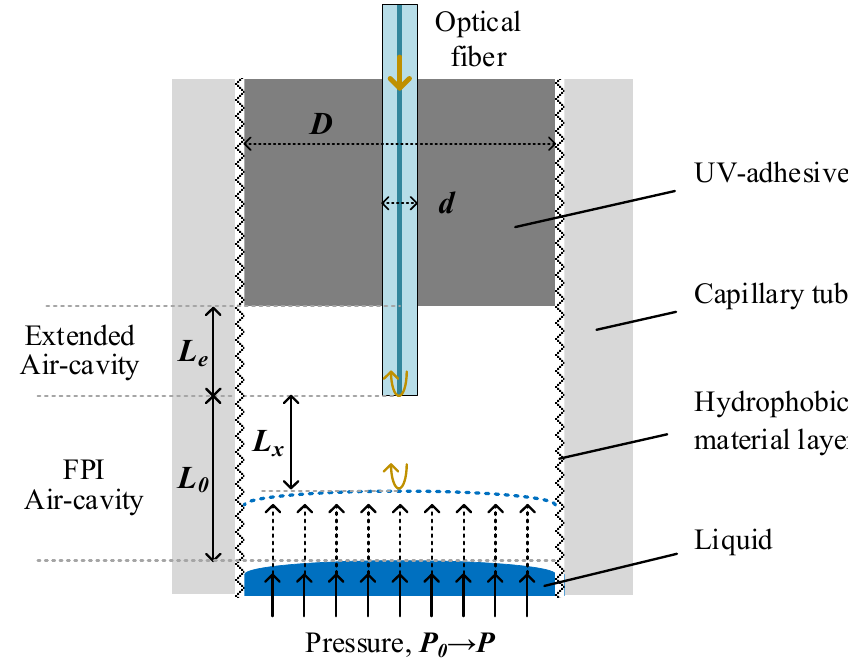
Figure 1. Schematic of pressure sensor with extended air